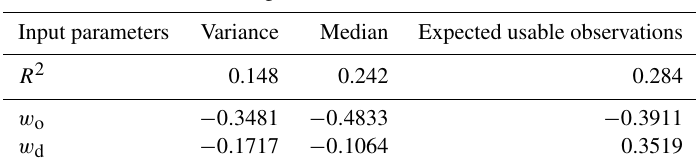
Table 5. The SRCs show that the median and variance of global error distributions are not sensitive to different weighting of the distance and overlap terms. R 2 < 0 . 7 usually signifies insensitivity to independent